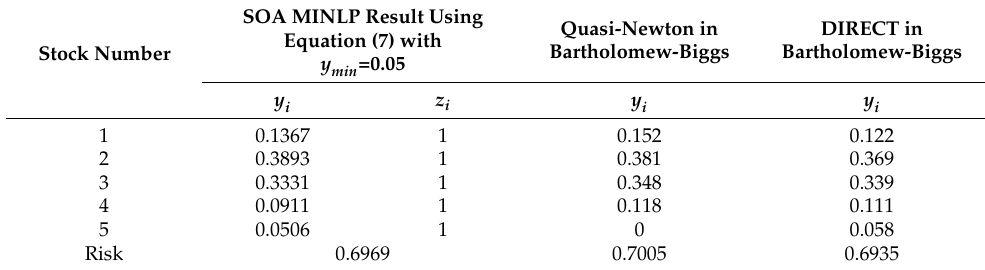
Table 1. Comparison result from SOA MINLP with the result of Bartholomew-Biggs and Kane for solving the portfolio optimization problem with a buy-in threshold constraint using data from Bartholomew-Biggs and Kane (2009).